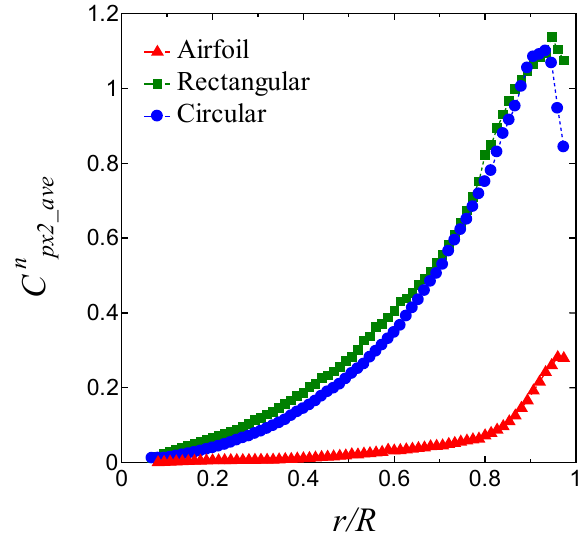
Figure 14. Distribution of the x 2 -direction pressure-based force coefficients, or pressure drag coefficient, on each arm. The data at the respective radial position were averaged over the seventh rotor-revolution using Equation (9).